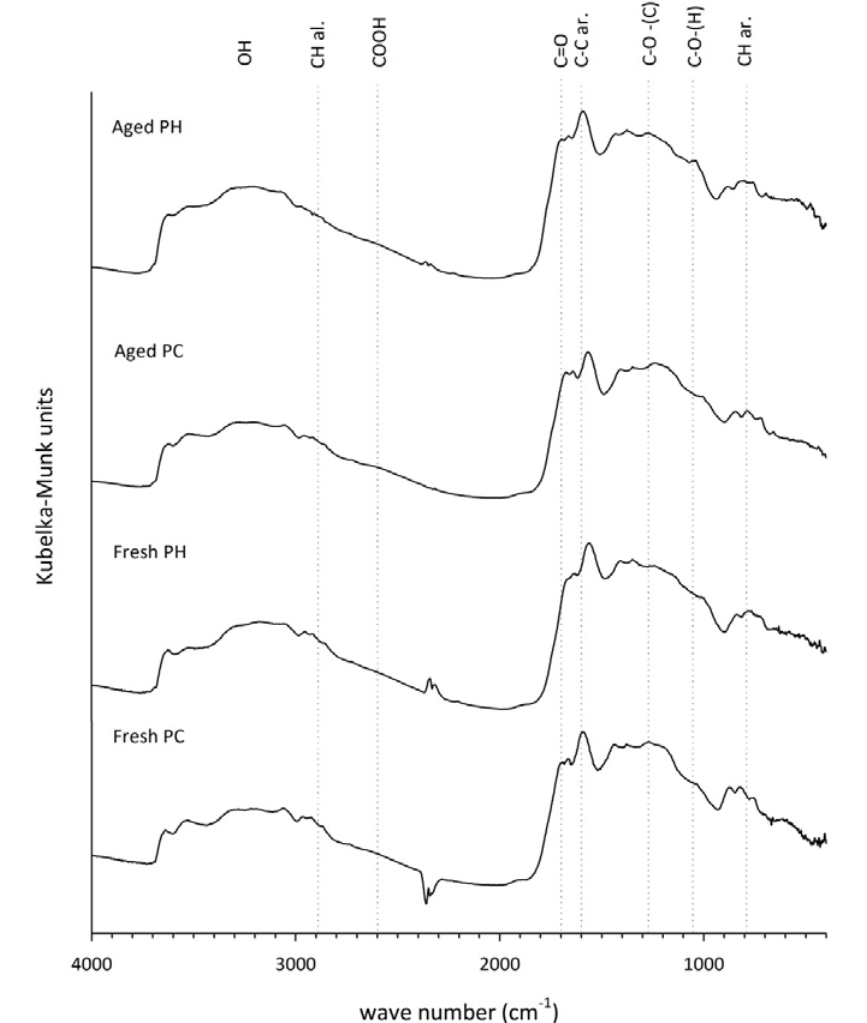
Figure 2. FTIR spectra of fresh PH and PC biochars, before incubation, and aged PH and PC biochars that were incubated in soil for 136-d. Dotted lines emphasize spectra of